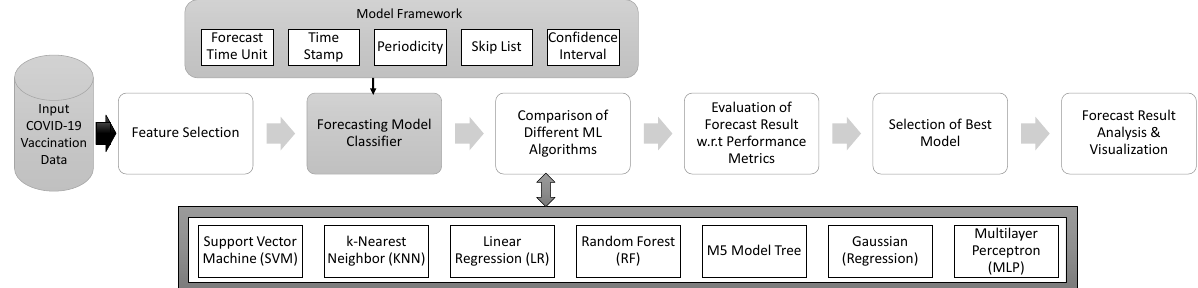
Figure 3. Workflow for COVID-19 vaccination forecasting model using